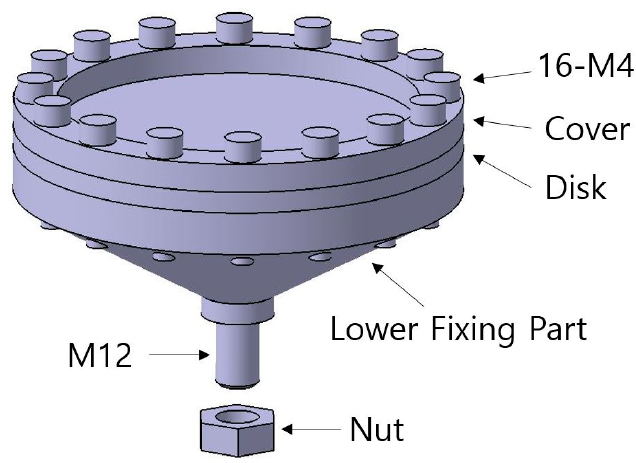
Figure 8. The 3D modeling of resonator.